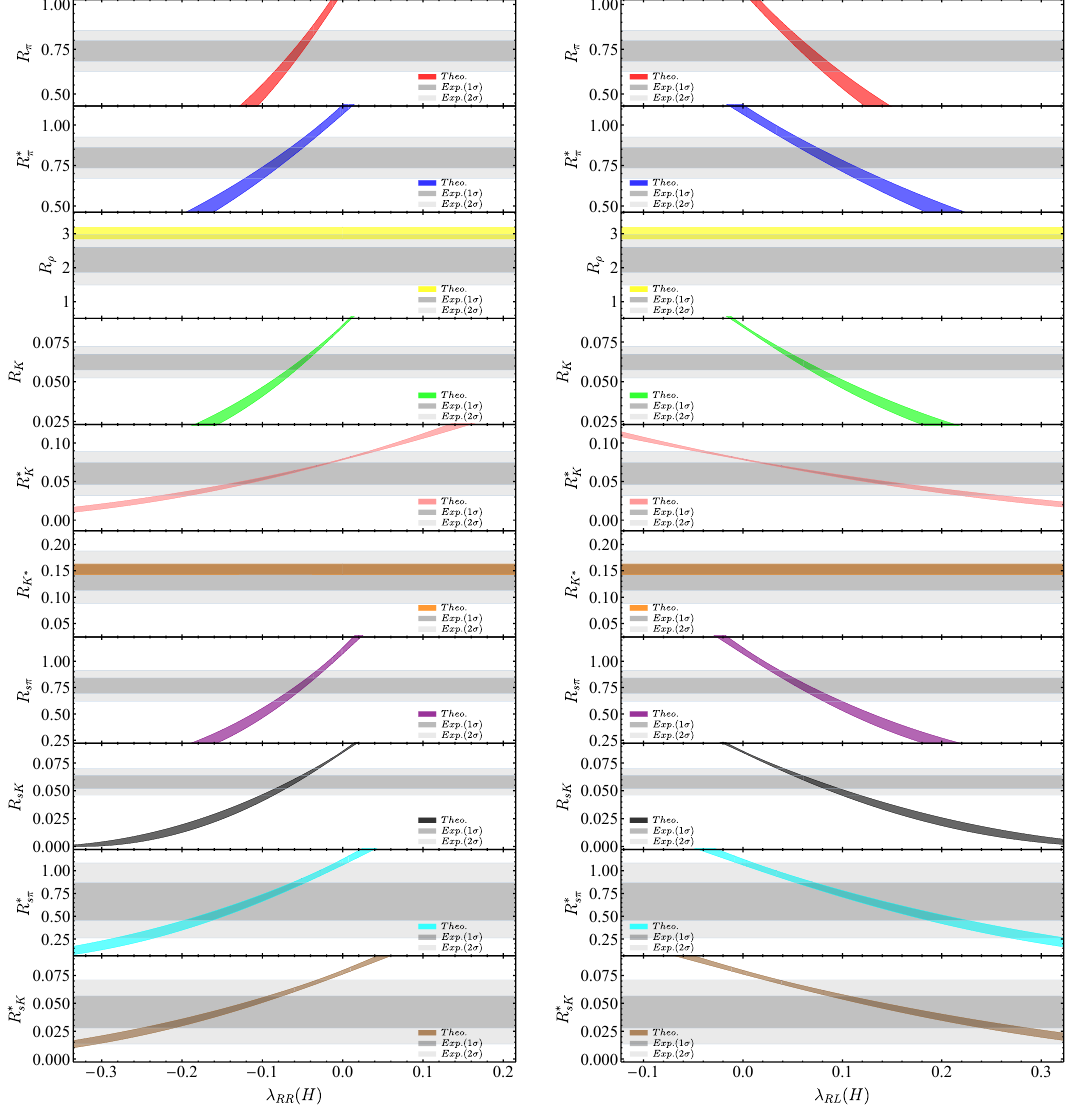
Figure 19 . Constraints on the effective coefficients λ RR ( H ) (left) and λ RL ( H ) (right) from the ratios R ( ∗ ) collected in table 6. The other captions are the same as in figure ( s ) L